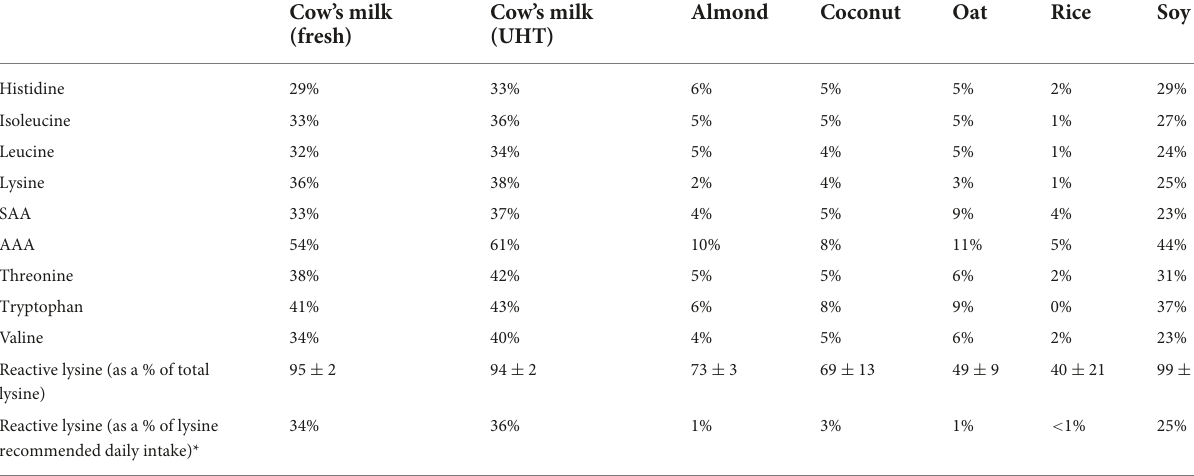
TABLE 4 Mean percentage of an adult woman’s recommended daily intakes for amino acids supplied by one 250 ml serving of each product